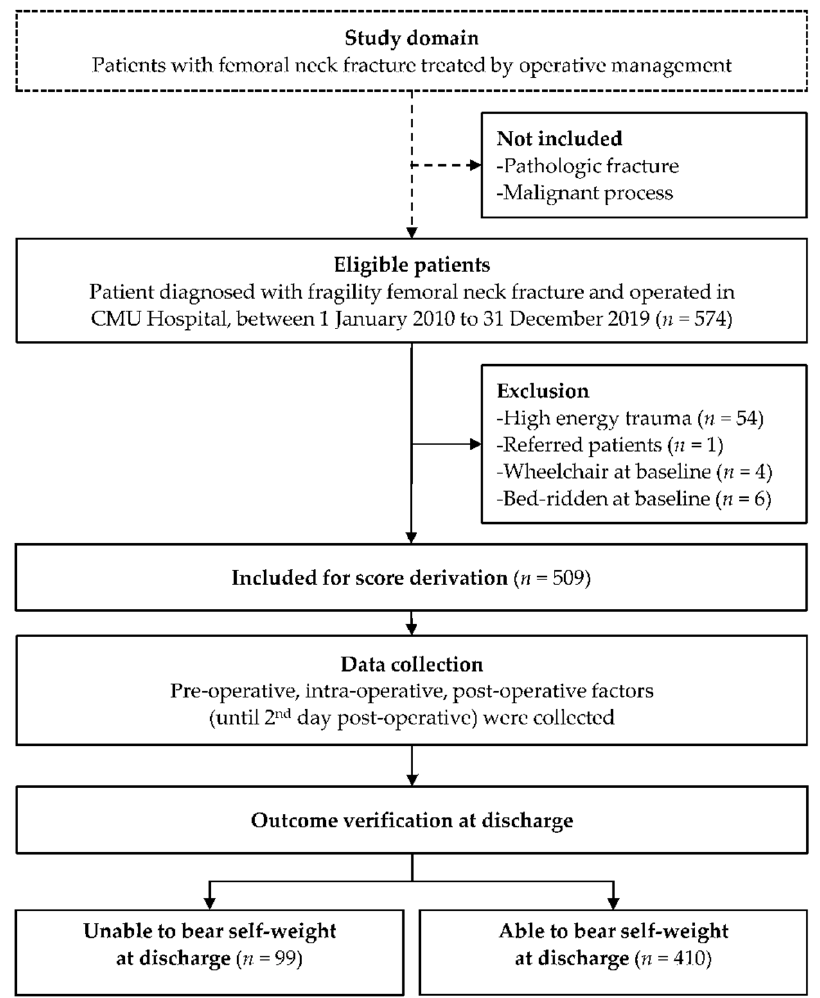
Figure 1. Study flow diagram of the patient cohort .